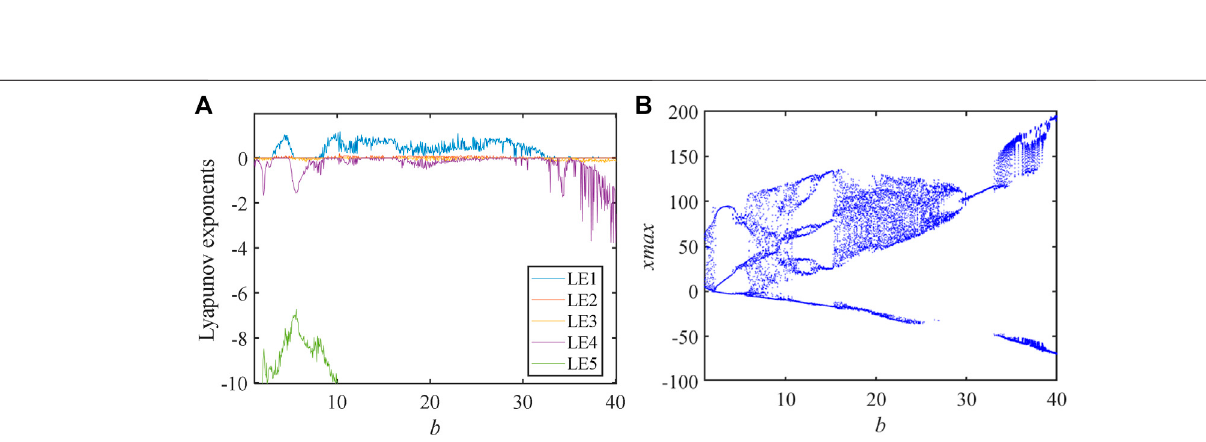
FIGURE 6 | Bifurcation diagram and LEs with parameter a , (A) LEs, and (B) bifurcation diagram.